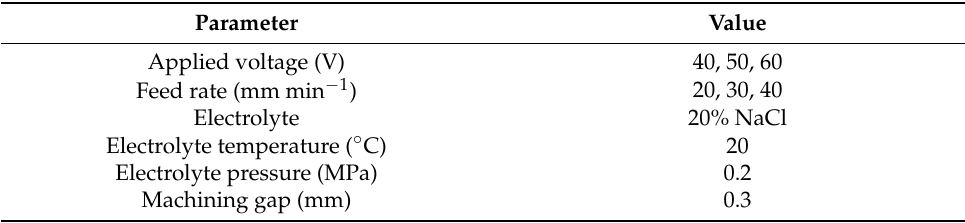
Table 4. Parameters of the single-groove milling experiment .